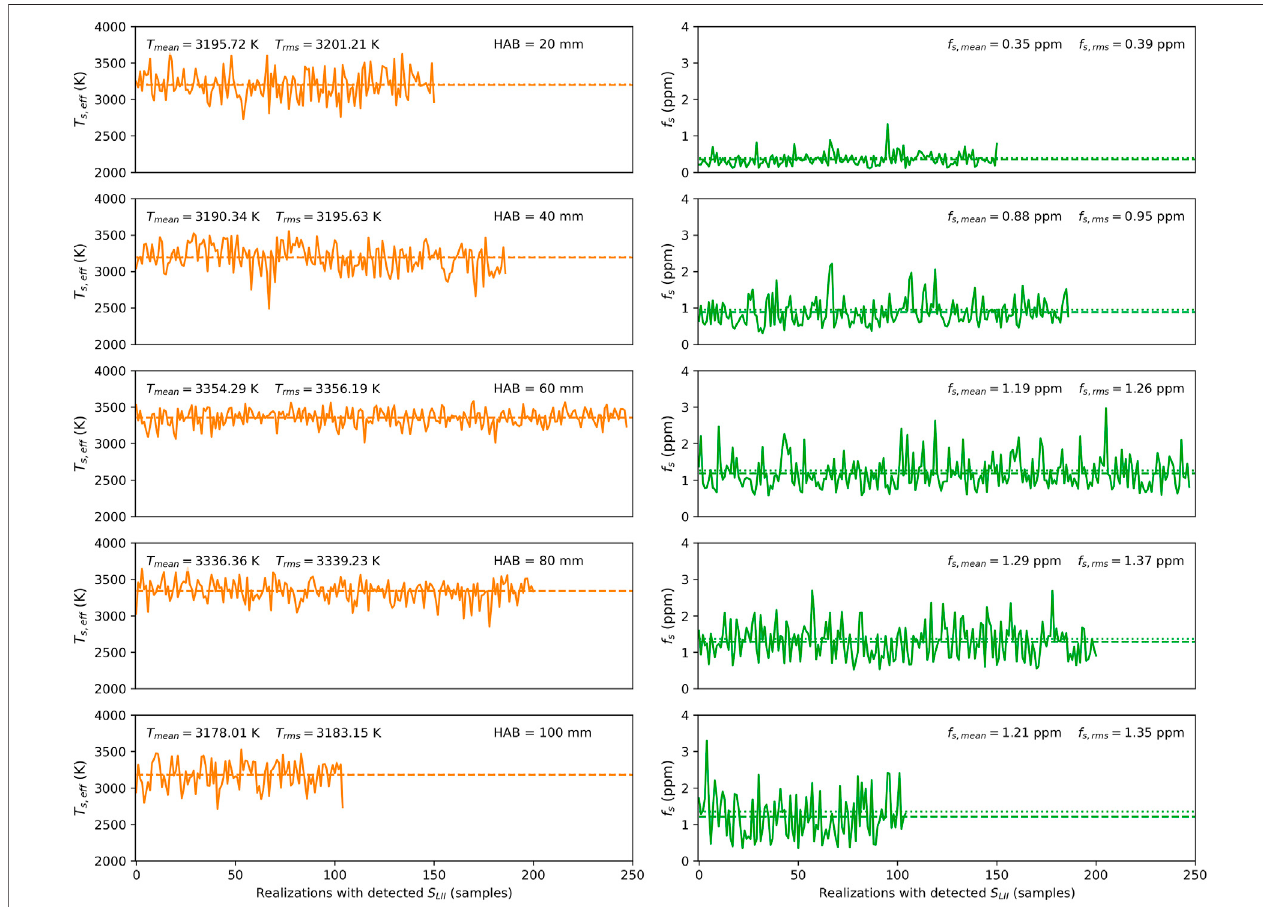
FIGURE 6 | Evolution of instantaneous effective soot temperature and volume fraction at different HABs. The fi gures also show the mean and root mean squared values of the instantaneous values for each soot property. These results are averaged between 35 and 60 ns after the laser pulse.